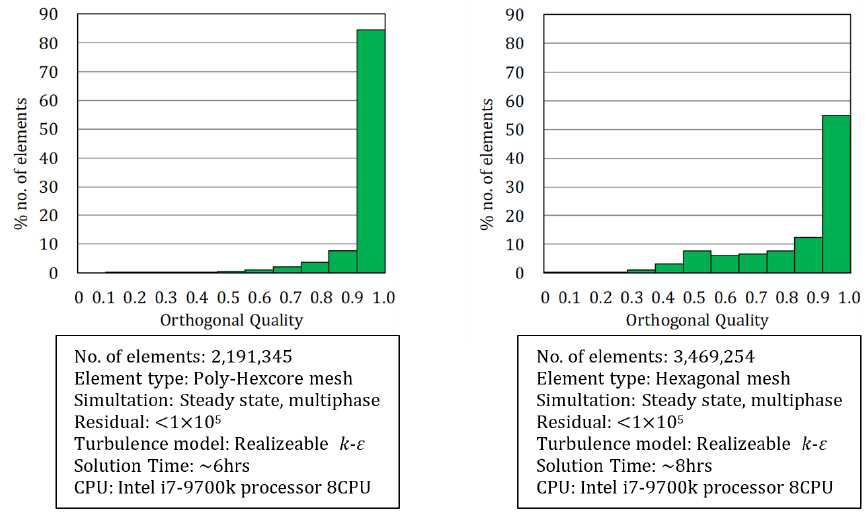
Figure 10. Element quality distribution for Poly-Hexcore and Hexagonal mesh models.